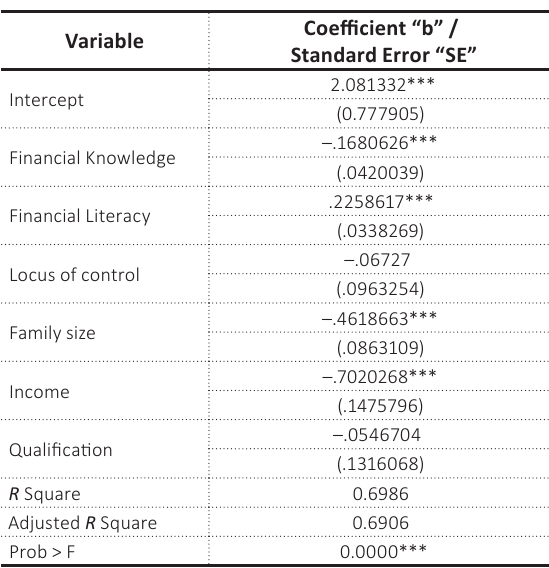
Table 4. WLS regression